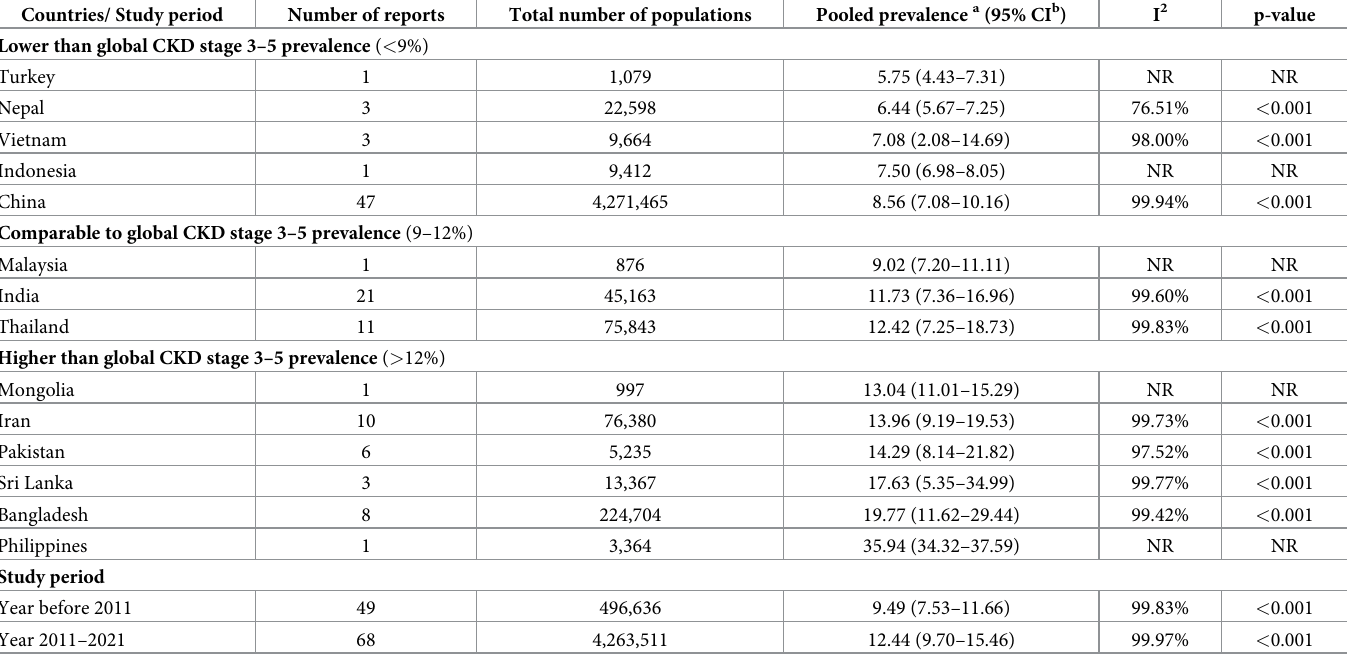
Table 2. Pooled estimate prevalence of chronic kidney disease (CKD) stages 3–5 in low- and middle-income countries (LMICs) by individual countries and in com- parison with global mean CKD stages 3–5 prevalence 2015 [1] and study period using a random-effects